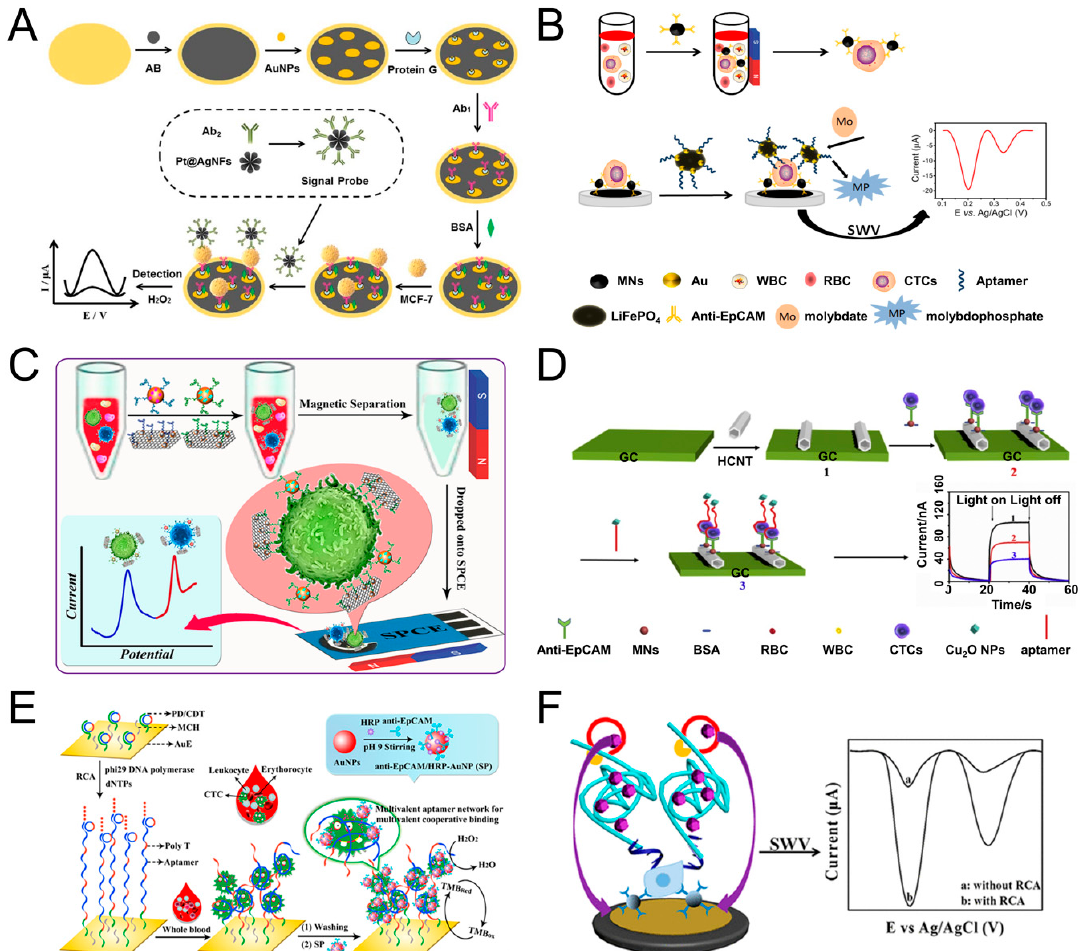
Figure 4. Sandwich electrochemical detection of CTC. ( A ) Voltammetric cytosensor for differential pulse voltammetry (DPV) detection of MCF-7 cells, using AuNPs/Acetylene black-antibody